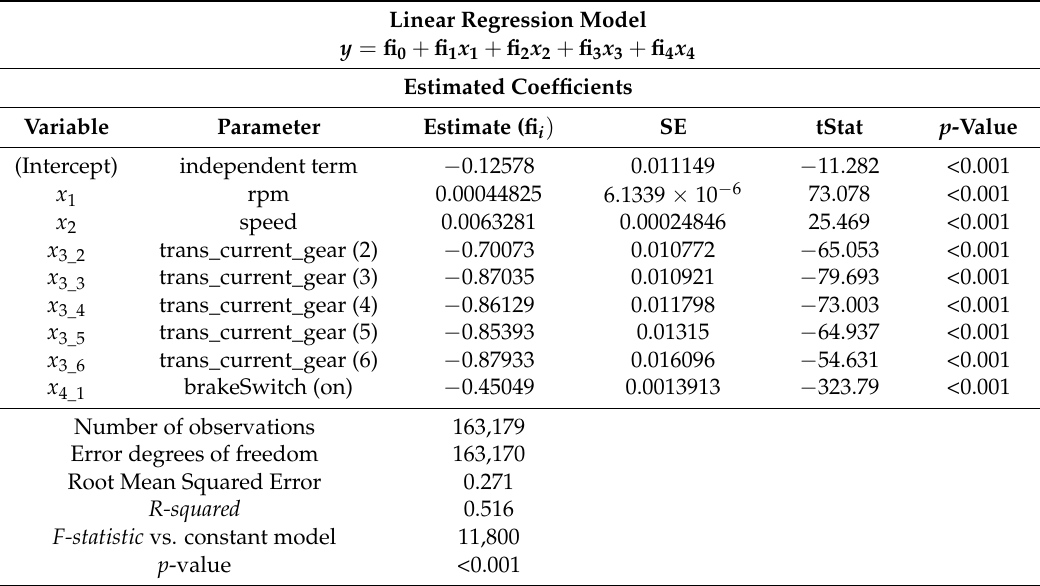
Table 3. Results of the second iteration. Linear Regression